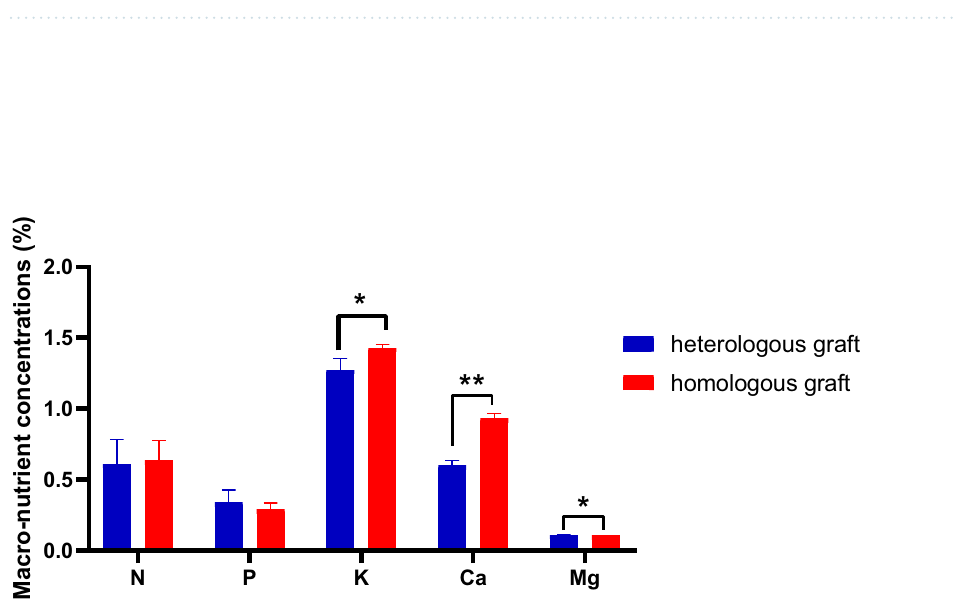
Figure 2. Rootstock influence on leaf macro-nutrient concentrations of scions. A significant difference between grafted groups was indicated by* ( P < 0.05) or ** ( P < 0.01) using the Student’ s